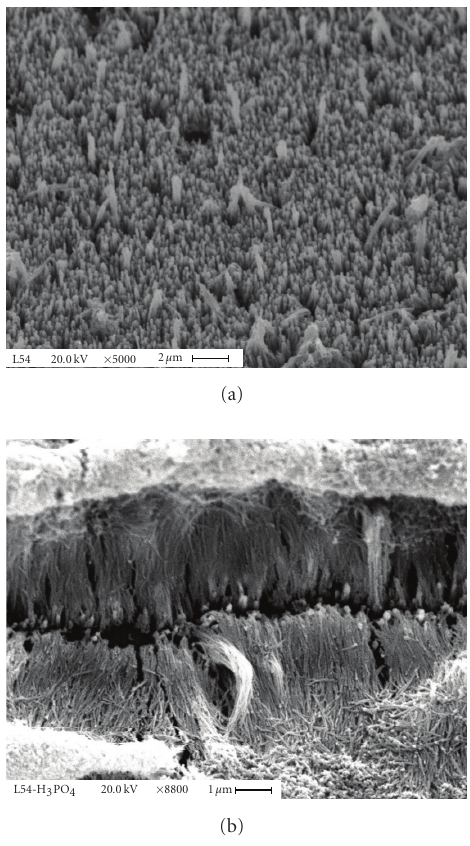
Figure 5: Top view FESEM image for fragments of Co nw arrays fabricated in the oxalic acid alumina pores by AC (50 Hz) deposition from the optimized solution at j ac ∼ 0.5 A dm − 2 ( U p − p from 18 to 32 V) and room temperature for (a) 10 and (b) 20 minutes. Before depositions, the barrier layer of the as-grown templates was thinned by decreasing anodizing voltage down to 20 V and etching in 0.5 M H 3 PO 4 at 30 ◦ C for 32 minutes. Following depositions the template was etched in the same 0.5 M H 3 PO 4